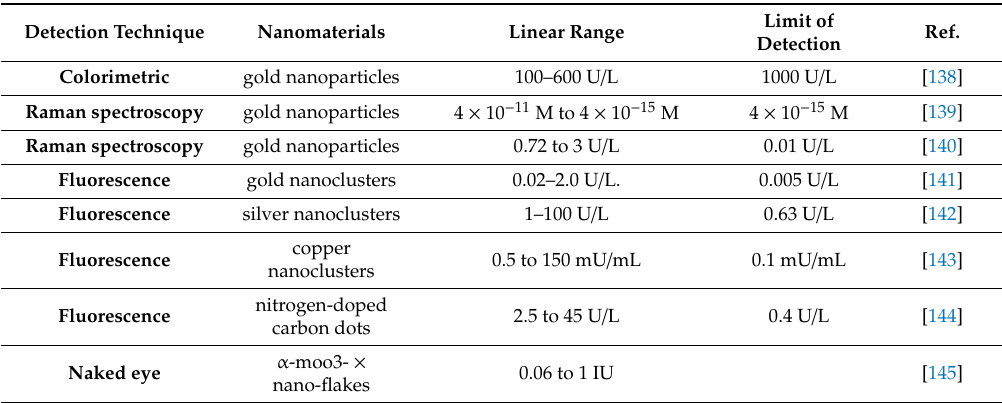
Table 1. Number of nanomaterials for enhancing optical